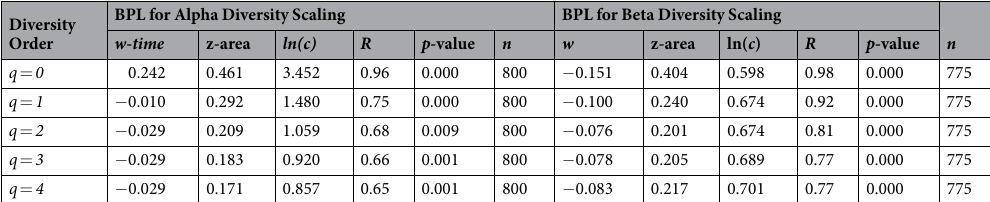
Table 3. The Bivariate Power Law (BPL) parameters for the Diversity Time Area Relationship (DTAR) for the 32-healthy cohort * . * The results are based on the averages of 50 repetitions, and the full results for all repetitions, are supplied in Suppl. Tables S2A and